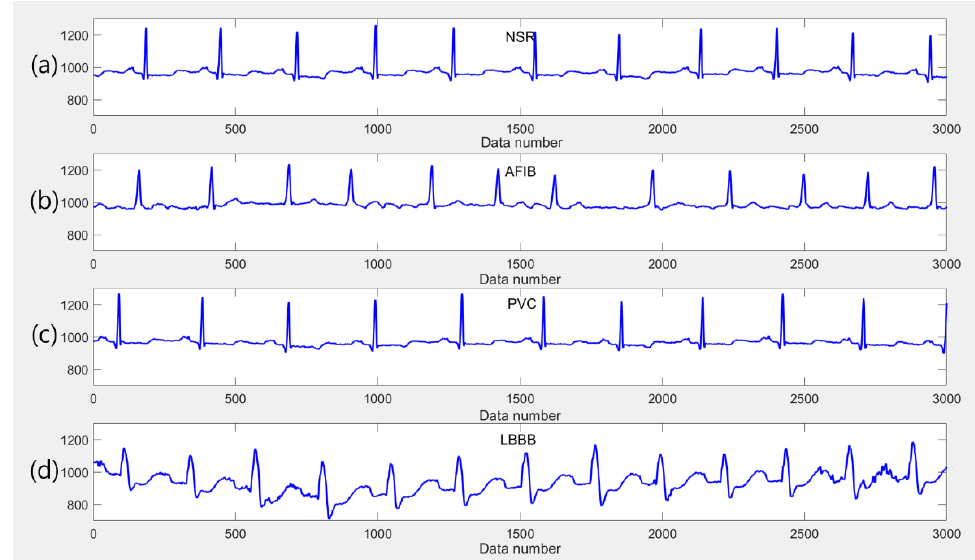
Figure 1. MIT-BIH database contained several ECG signals. The recordings were digitized at 360 samples per second per channel with a resolution of 11 bits: ( a ) NSR; ( b ) AFIB; ( c ) PVC; ( d ) LBBB. Two or more cardiologists independently annotated each record.